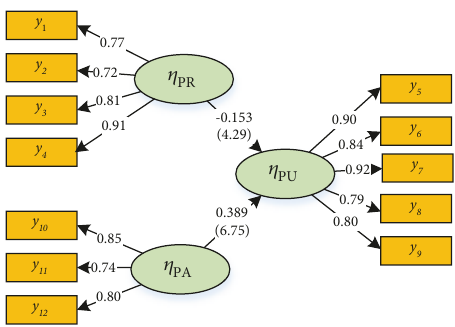
Figure 5: MIMIC submodel for ticketing agencies.